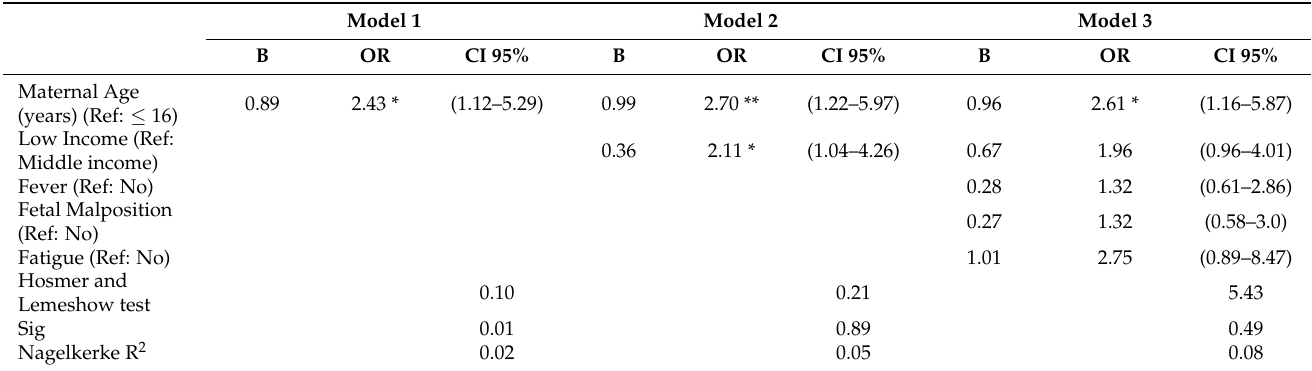
Table 4. Hierarchical logistic regression models for antenatal care